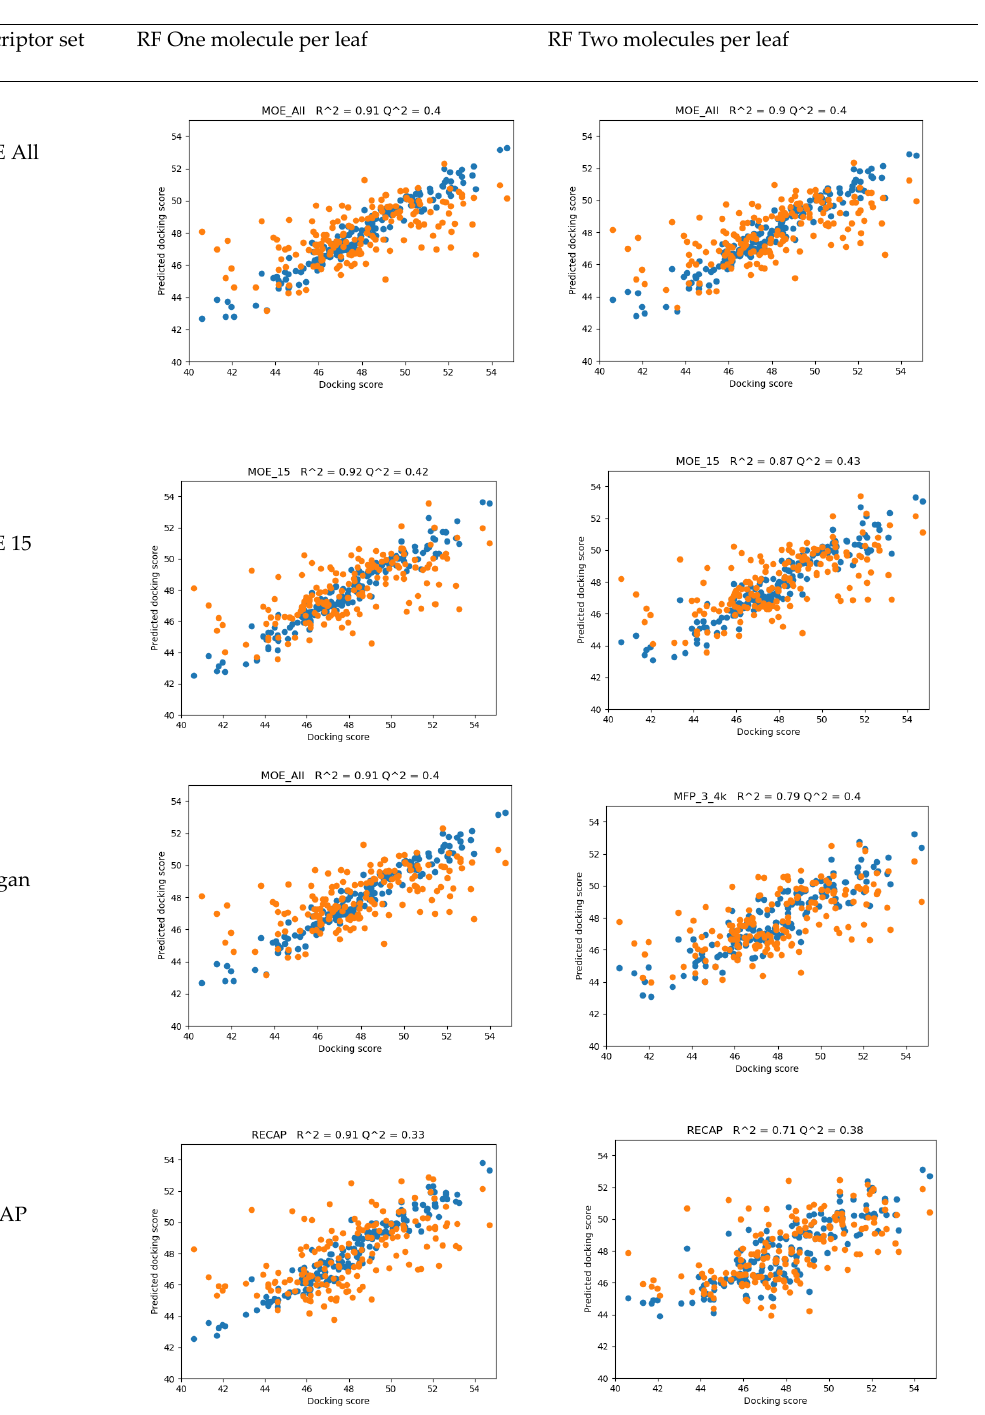
Figure 2. Results of the evaluation of Random Forest Regressor models on the training set (blue points) and leave-one-out cross-validation (orange points) for various considered descriptor sets.